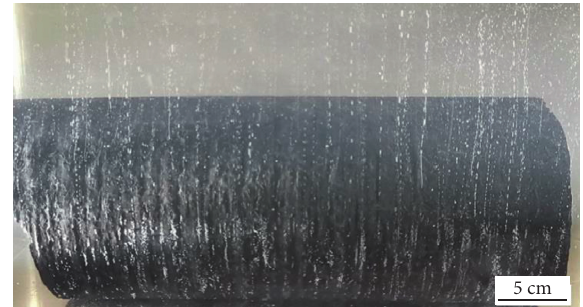
Figure 12: Schematic diagram of gray-black shale core immersion test. The gray-black shale of the Da 2 submember of Da’anzhai Member is better, and many needle-like, granular bubbles are found intermittently in the shale, North-2 Well, 3909.78 ∼